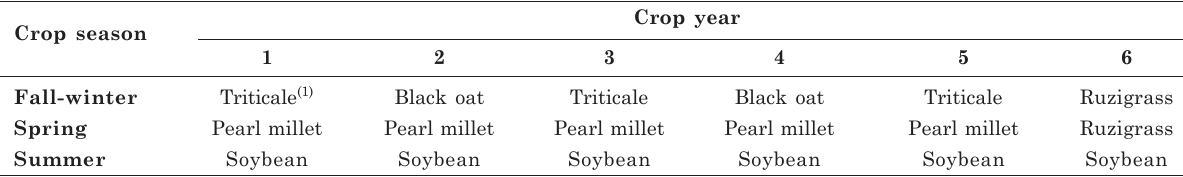
Table 2. Crop rotation system at the experimental site